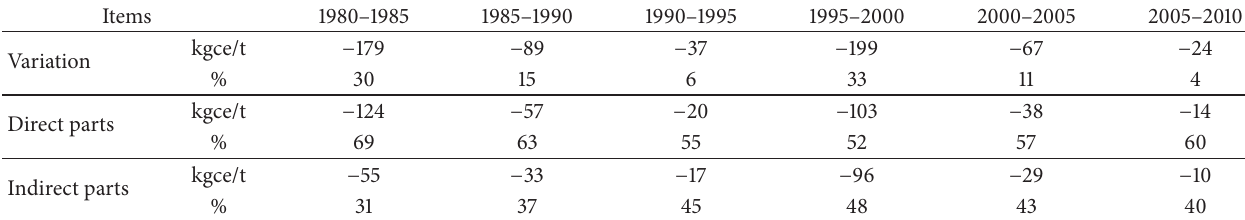
Table 3: Variation and effect of energy consumption per ton of crude steel for CSI during 1980–2010.